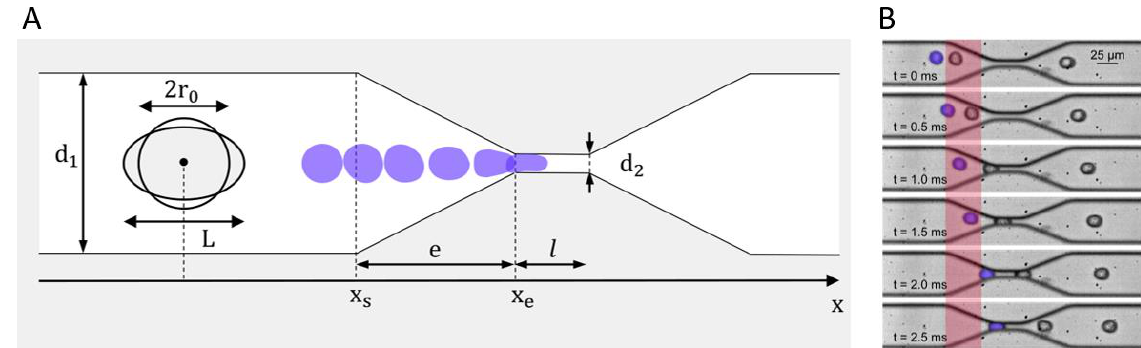
Figure 4. ( A ) Design of the microfluidic stenosis narrowing from diameter d 1 to diameter d 2 over the elongational length e. The cell deforms from a round shape with its original diameter d = 2r 0 to an ellipse with major axis L. ( B ) Exemplary micrographs of A375 cells passing a standard elongation d = 7 µm stenosis. The area for the deformation analysis is highlighted in red.